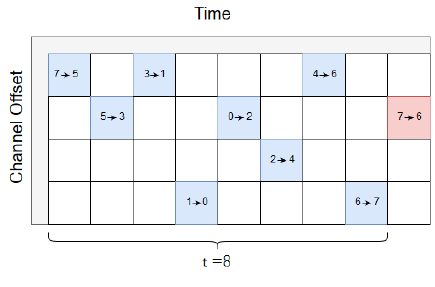
Figure 7. Scheduling a delay of τ =